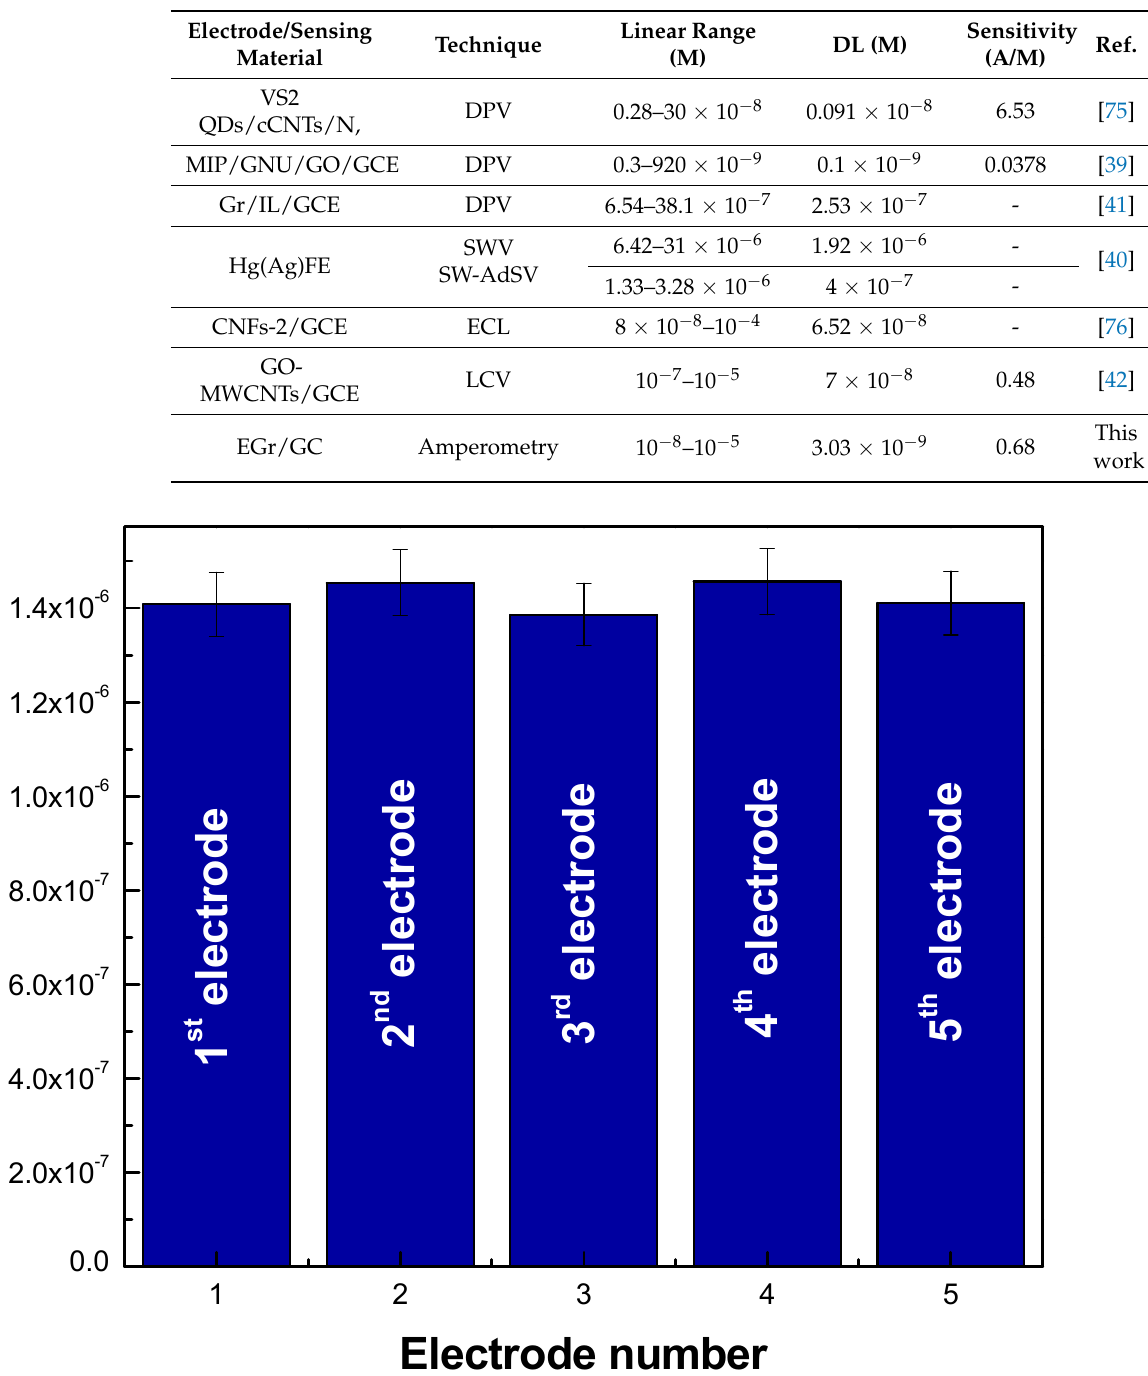
Table 1. The comparison between the electrochemical performance of EGr/GC electrode with those of other modified electrodes employed for the determination of AZT.